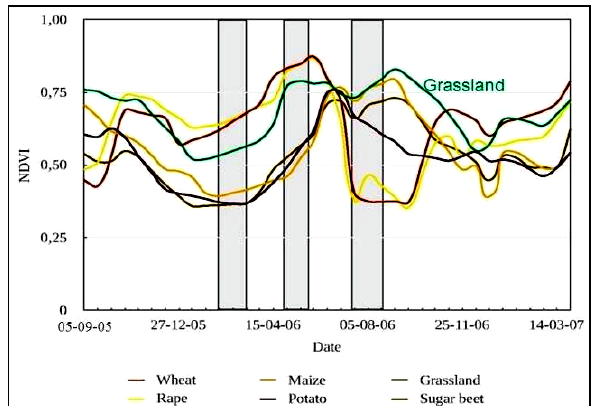
Figure 2: Average phenology curves derived from MODIS NDVI for wheat, rape, maize, potatoes, sugar beets and grassland showing potential intervals for a separation of cropland and grassland (grey intervals; source: Metz, 2009,